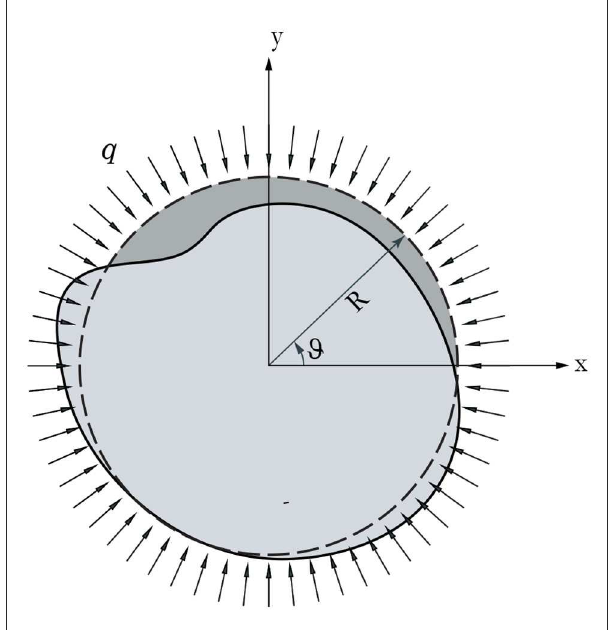
FIGURE3 Circular ring under external hydrostatic pressure. Dashed and continuous lines mark the initial undeformed configuration and the buckled configuration of the ring, respectively.